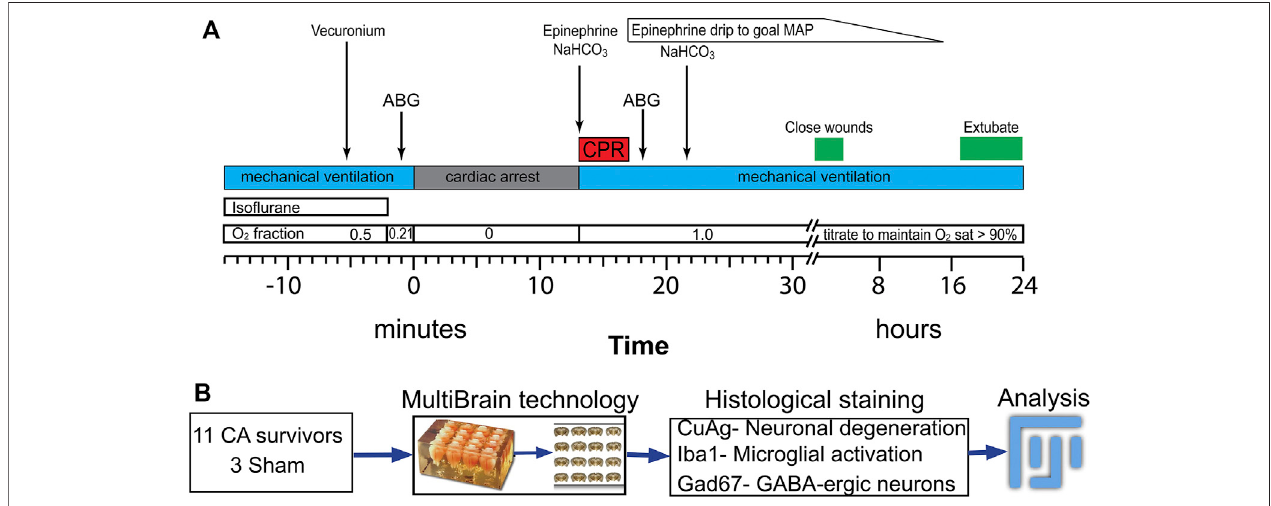
FIGURE1| Procedureforasphyxiacardiac arrestand resuscitation experiment followingbytissueprocessingforhistologicalstudy (A) Timelineand procedure for anestheticwashout,asphyxia,PCRandpost-ROSCperiods. (B) Experimentalprocedureforhistologicalstainingandanalyzingafter24 hafterinsults.ABP:arteryblood pressure; ECG: electrocardiogram; CA: cardiac arrest; CPR: cardiopulmonary resuscitation; ROSC: return of spontaneous circulation; MAP: mean arterial pressure.